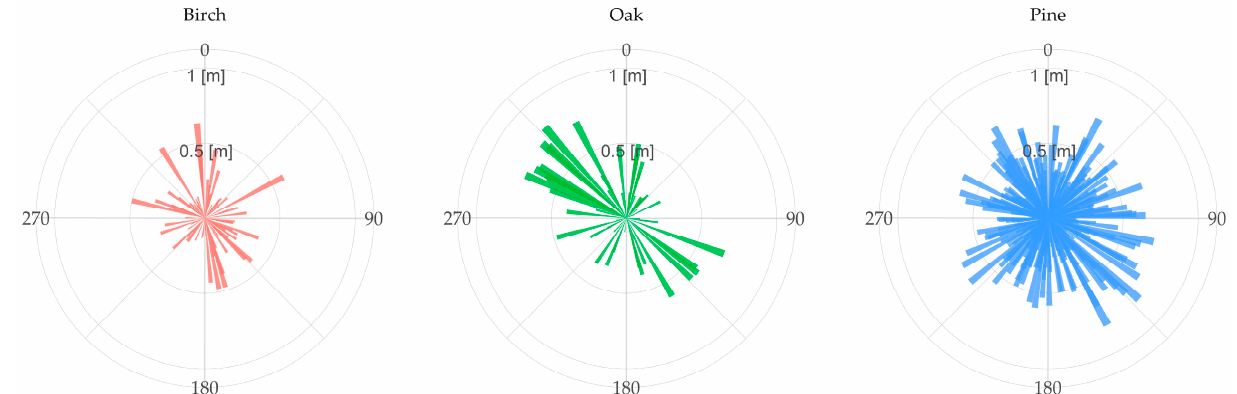
Figure 6. The RMSE value (expressed in meters) and the azimuth (expressed in degrees) for every